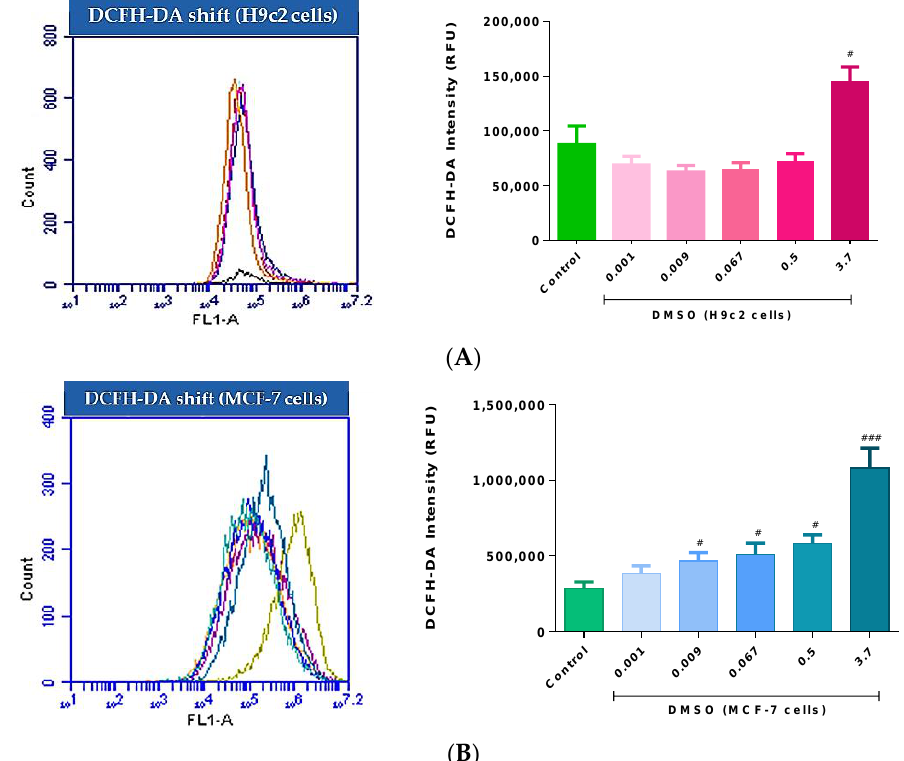
Figure 4. The effect of dimethyl sulfoxide (DMSO) on the production of reactive oxygen species (ROS) in ( A ) fluorescent shift of H9c2 cardiomyoblasts and ( B ) fluorescent shift of MCF-7 breast cancer cells. Cells were treated every second day for 6 days with varying DMSO concentrations (0.001, 0.009, 0.067, 0.5, and 3.7%). Data are presented as the mean ± SEM of 3 biological experiments with 3 technical repeats ( n = 3). Significance is indicated as # p < 0.05, ### p < 0.001 versus the control.